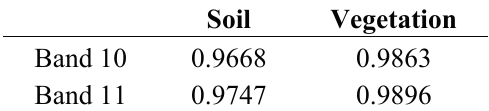
Table 4. Emissivities of soil and vegetation for Landsat 8 TIRS band 10 and 11.